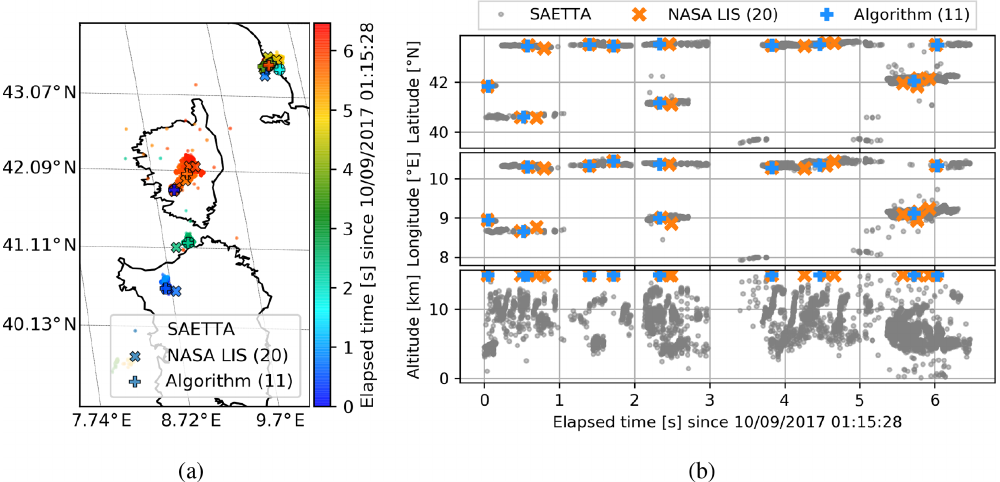
Figure 3. The map (a) and time series (b) of SAETTA observations and the mean flash positions based on the NASA LIS algorithm and our developed algorithm for one situation on 10 September 2017. The numbers in parentheses in the legend indicate the number of identified flashes (both algorithms analyzed the same LIS events). Colors in (a) represent the elapsed time from the initial lightning activity. Note: flash altitudes in (b) are not known for ISS-LIS flashes but arbitrarily plotted at